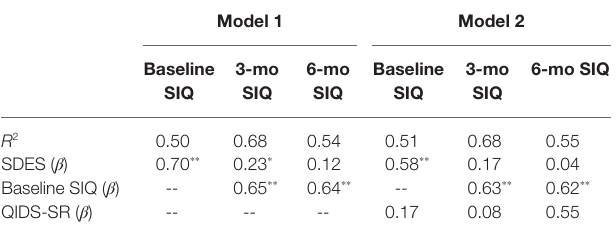
TABLE 2 | Cross-sectional and prospective linear regression analyses predicting suicidal ideation by defeat/entrapment and depressive